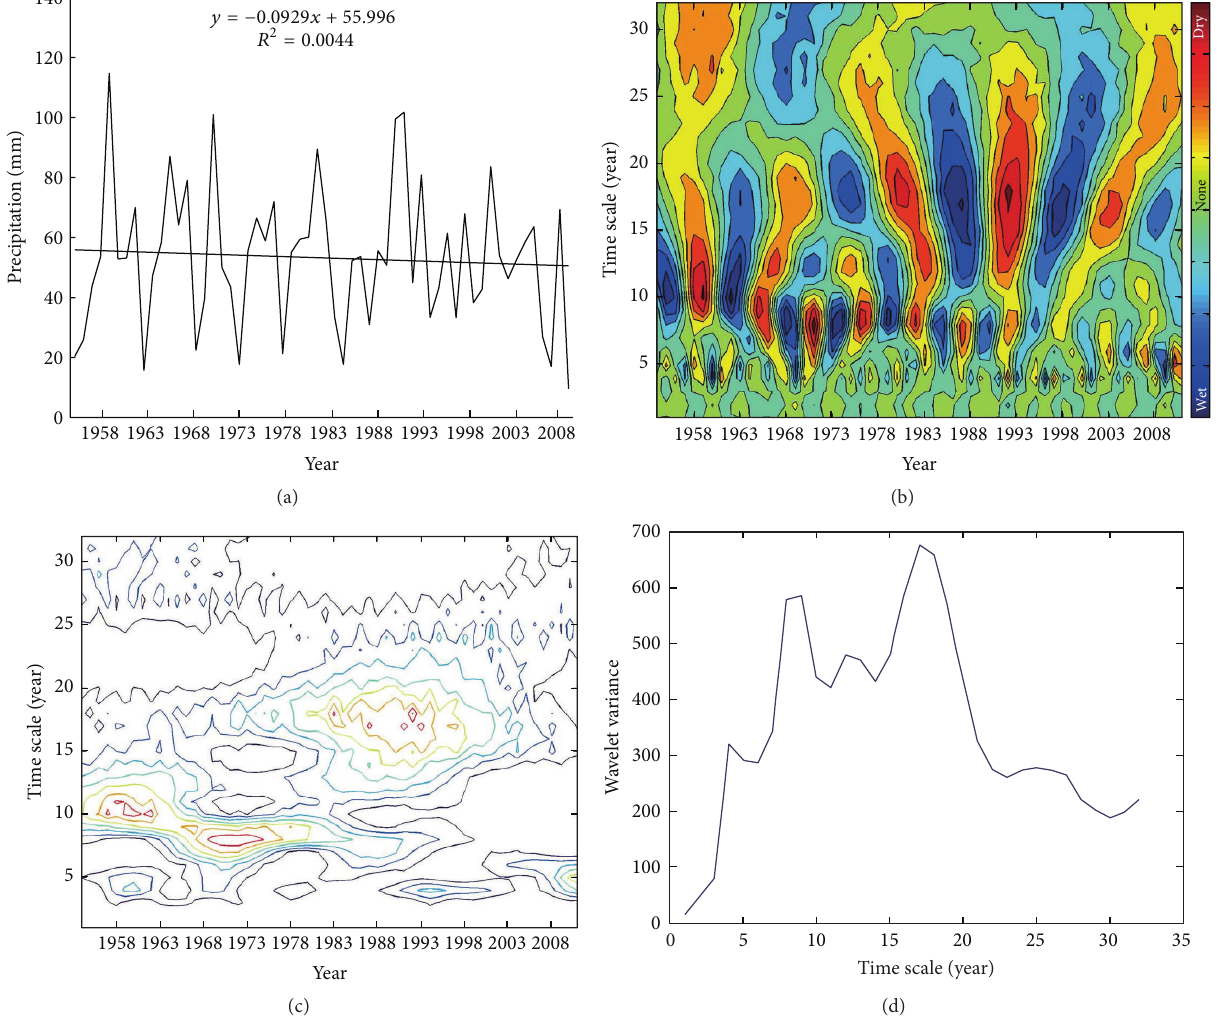
Figure 5: (a) Winter precipitation interannual change of Yunnan. (b) Winter precipitation wavelet transform of Yunnan. (c) Winter precipitation wavelet coefficients contour of Yunnan. (d) Winter precipitation wavelet variance of